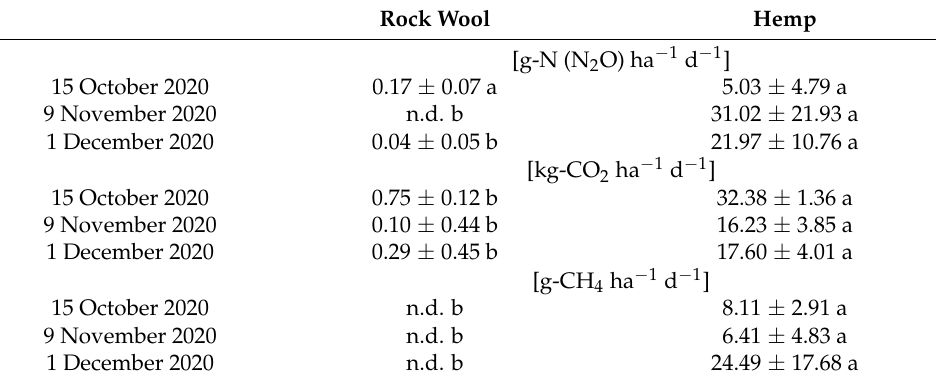
Table 3. Emissions of greenhouse gases from hemp and rock wool.